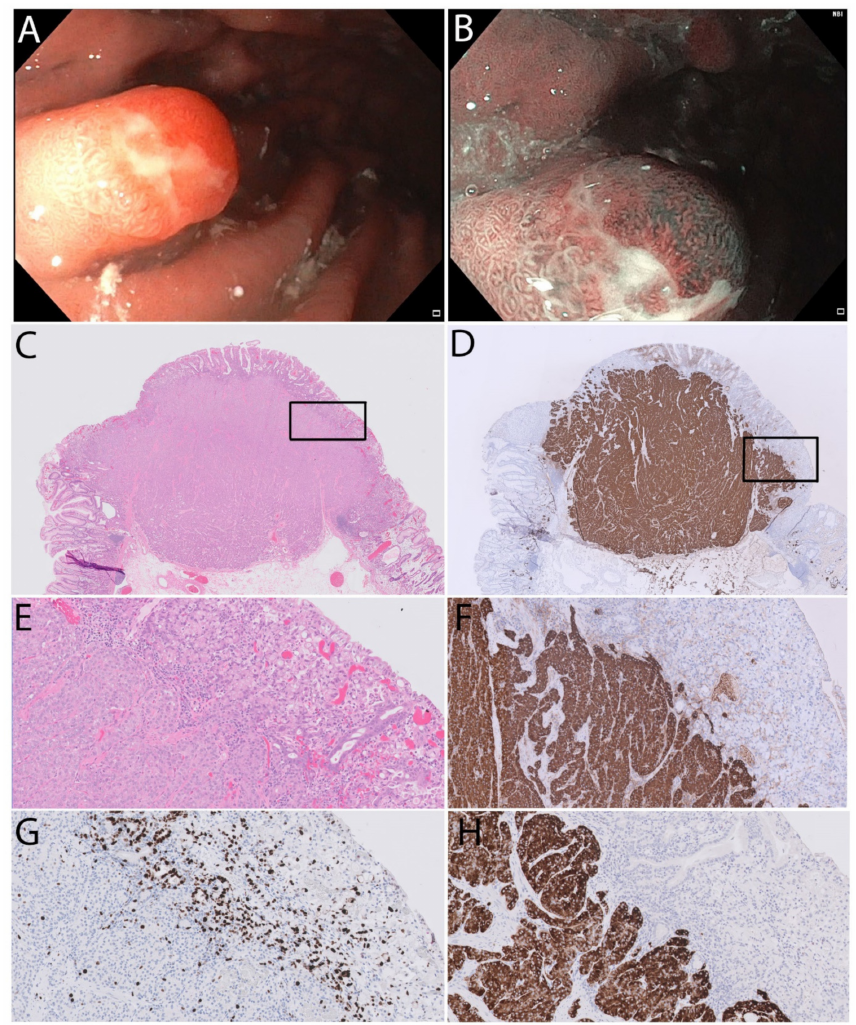
Figure 1. Endoscopic appearance of a polyp located at the major curvature with white light ( A ) and narrow band imaging ( B ). The HE stained sections ( C , E ), chromogranin A ( D , F ), and synaptophysin ( H ) sections demonstrated well-differentiated neuroendocrine tumour (NET) tissue combined with signet ring cell carcinoma. The proliferation rate evaluated by Ki-67 positivity in the NET component was up to 4% compared to 40% in the signet ring cell component ( G ). The black rectangle in ( C ) is seen at higher magnification as ( E ) and the black rectangle in ( D ) is seen at higher magnification as ( F ). The lower left half of ( E – H ) contains NET tissue while the upper right part contains the signet ring cell